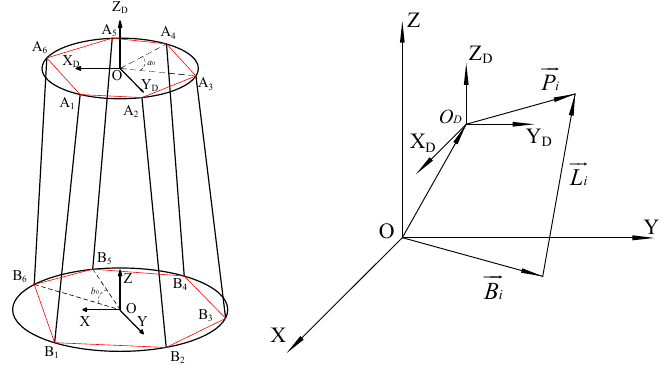
Figure 4. Explanation of the spatial position vector